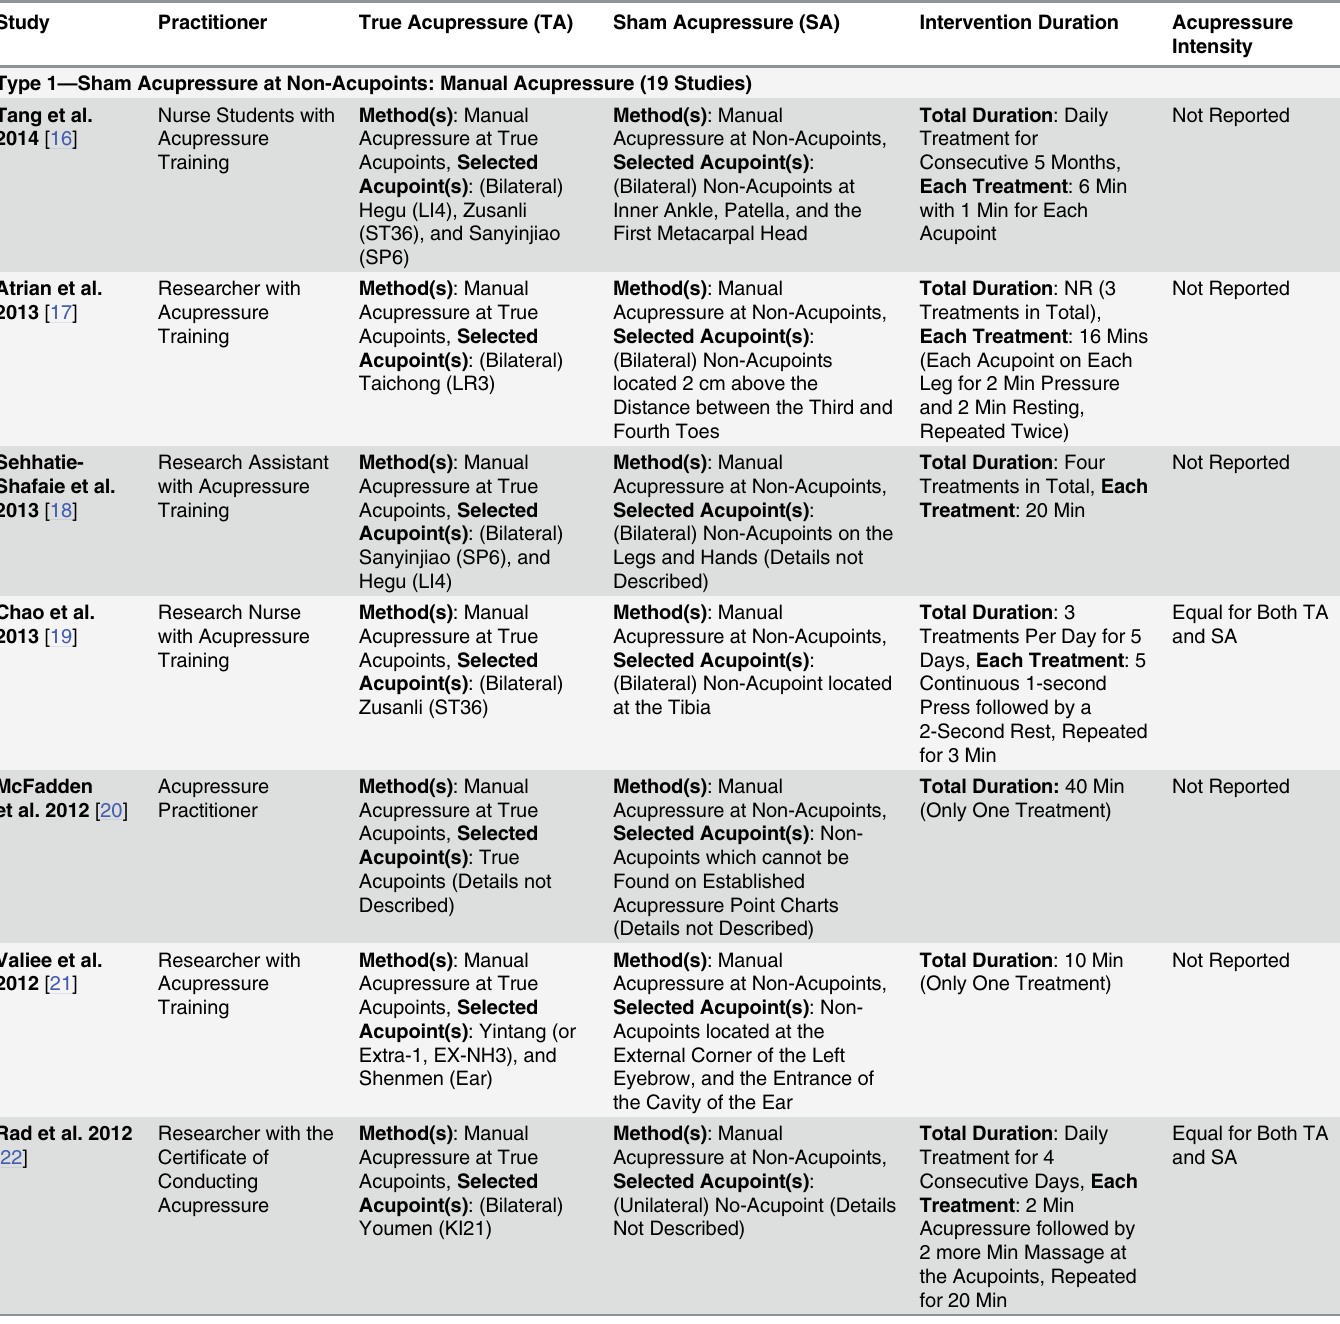
Table 3. True and Sham Acupressure Protocols of the Included